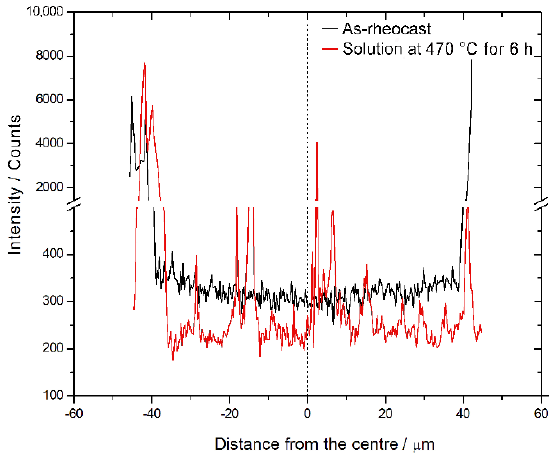
Figure 9. The distribution of Si across the width of an α -Al crystal in as-rheocast condition and after 6 h of solution treatment at 470 °C.